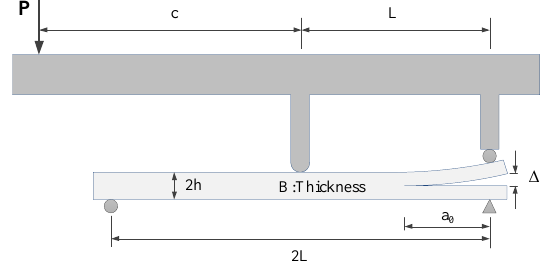
Figure 10. Mixed-mode bending (MMB) test configuration.